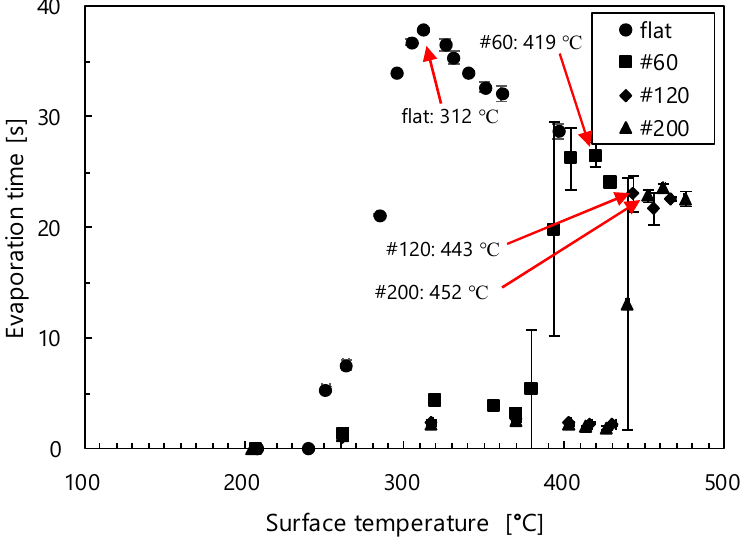
Figure 6. Evaporation time as a function of surface temperature on flat and mesh surfaces.